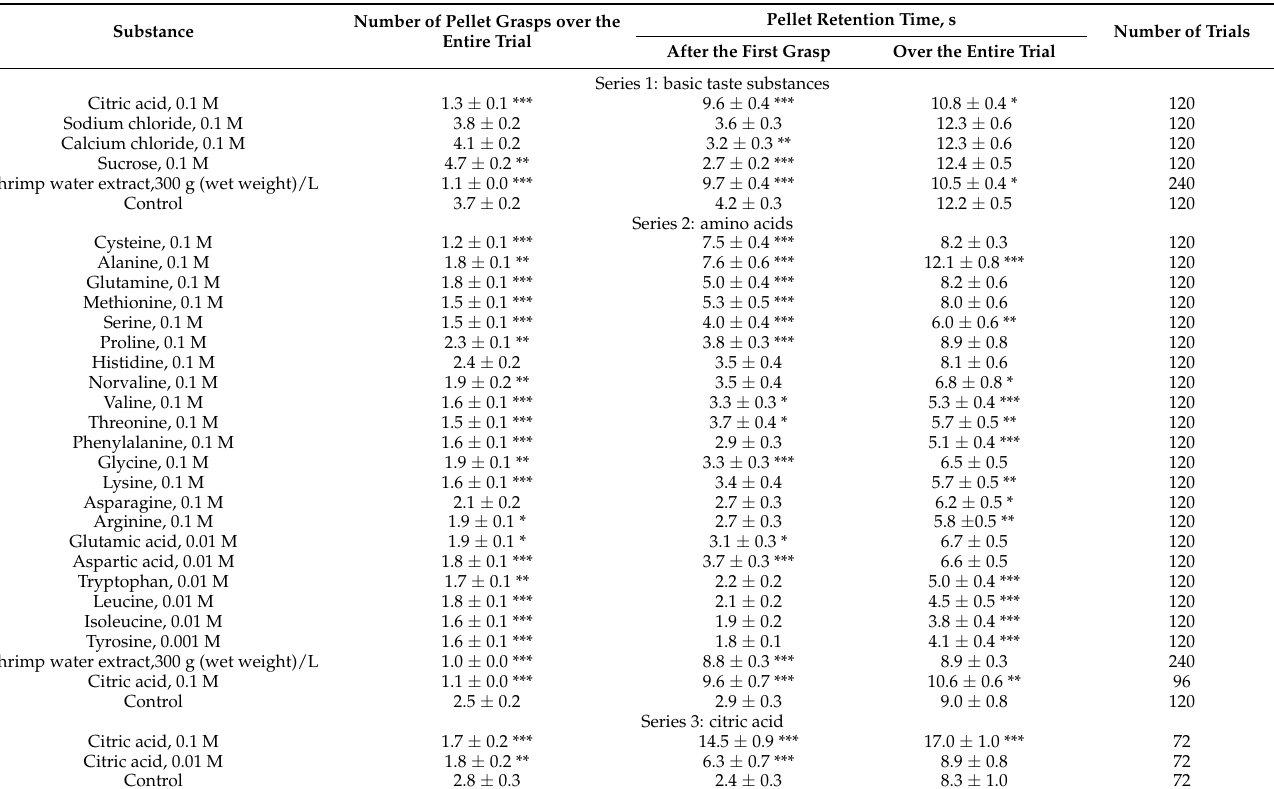
Table 1. Behavioral taste responses of barramundi Lates calcarifer to pellets of agar gel (2%) flavored with 4 basic taste substances, 21 L-amino acids and shrimp Penaeus vannamei water extract. *, **, and ***—differences from the control are significant at p < 0.05, p < 0.01, and p < 0.001, respectively (Mann–Whitney